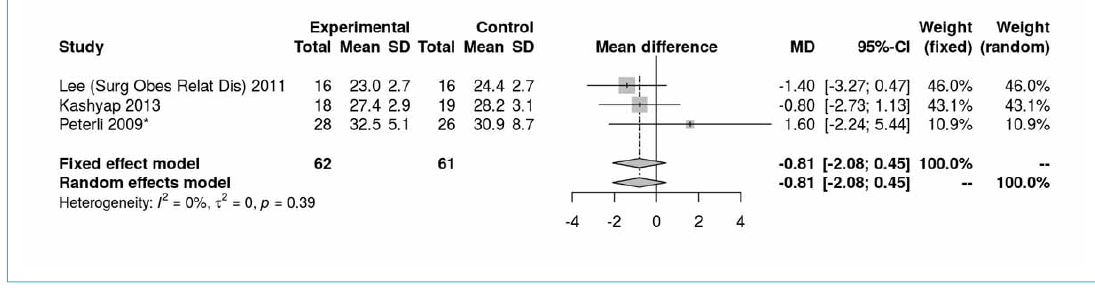
Figure S6c: Fasting blood glucose at baseline (analysis of studies including only patients with type 2 diabetes).